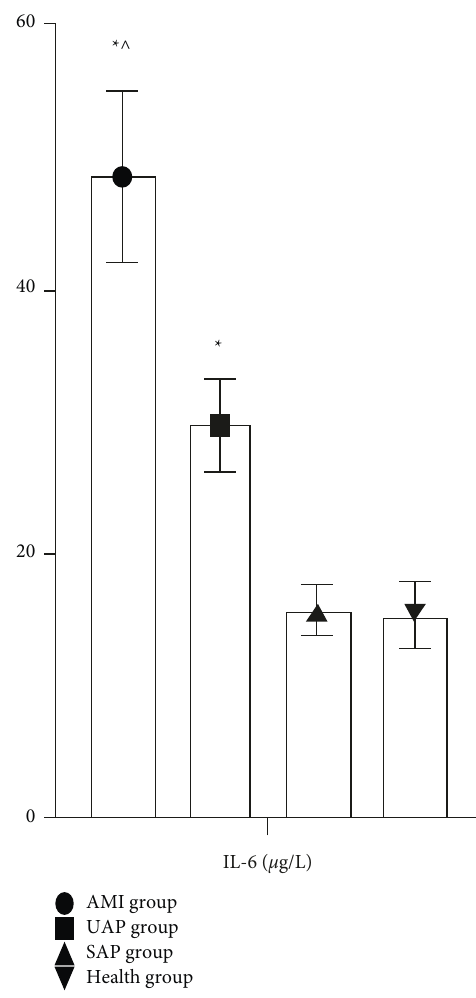
6: Serum IL-6 level ( μ